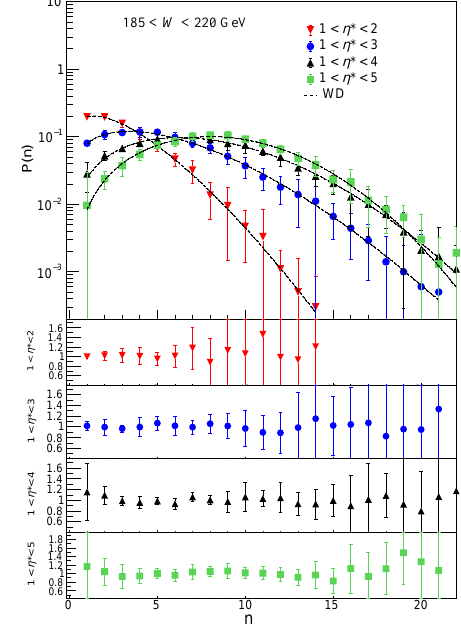
Figure 9. Multiplicity distributions fits with the WD probability function in 185 < W < 220 GeV in different η ∗ ranges of the H1 data [33]. The lower panel shows the data/WD-fit ratio plots for different η ∗ regions. Table 2. Weibull distribution, Equation (A1), fit parameters k , λ with C as the normalisation constant for the multiplicity distributions for n > 0 in different W ranges of the H1 data